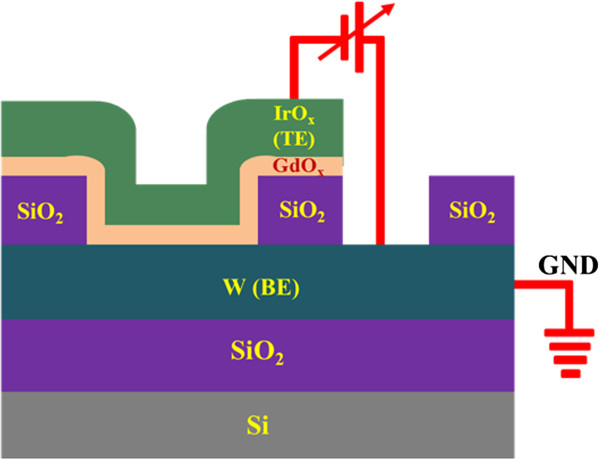
Schematic view of resistive switching memory device in an IrOx/GdOx/W via-hole structure. Typical device size is 2 × 2 μm2.